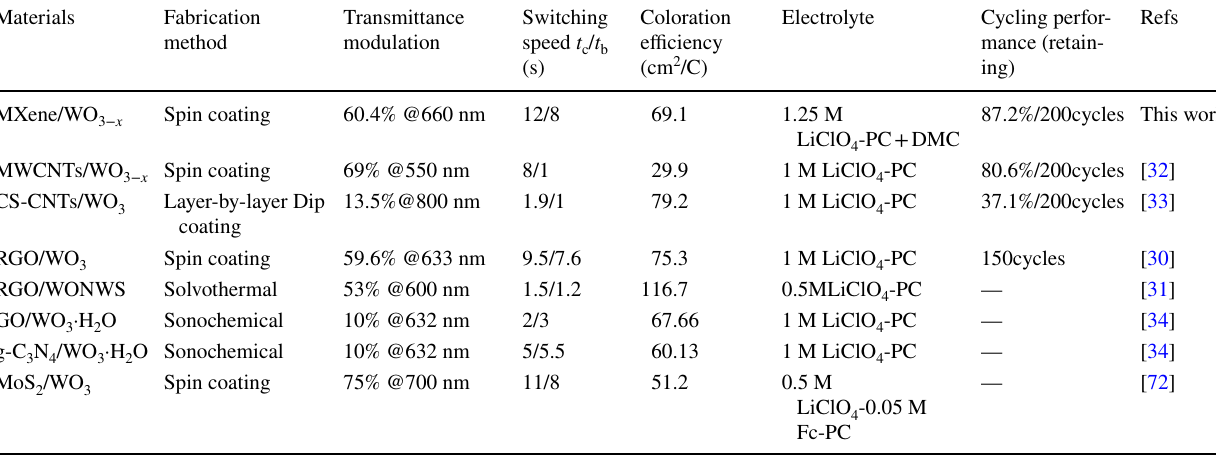
Table 1 Electrochromic performances of tungsten oxide nanocomposite film